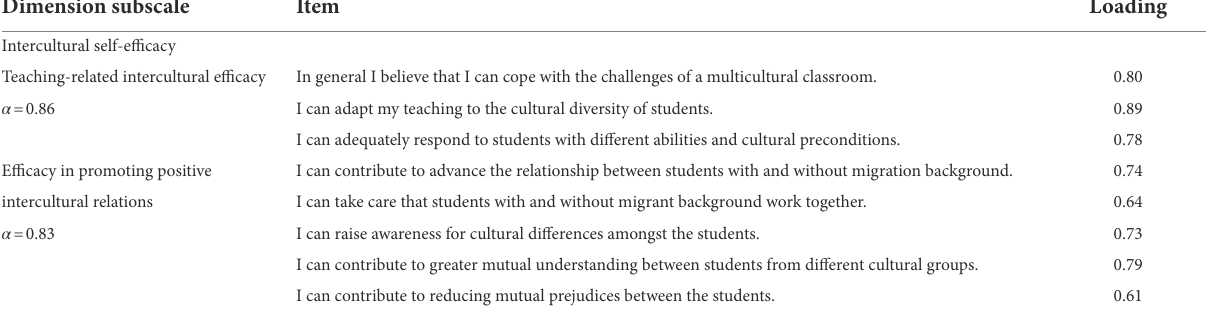
TABLE 1 Intercultural self-efficacy items, standardized factor loadings and reliabilities. Dimension subscale